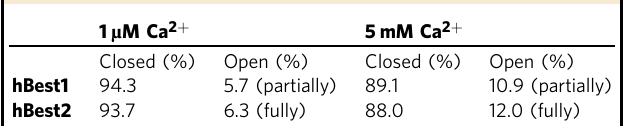
Table 1 Composition of bestrophin particles under different Ca 2 +